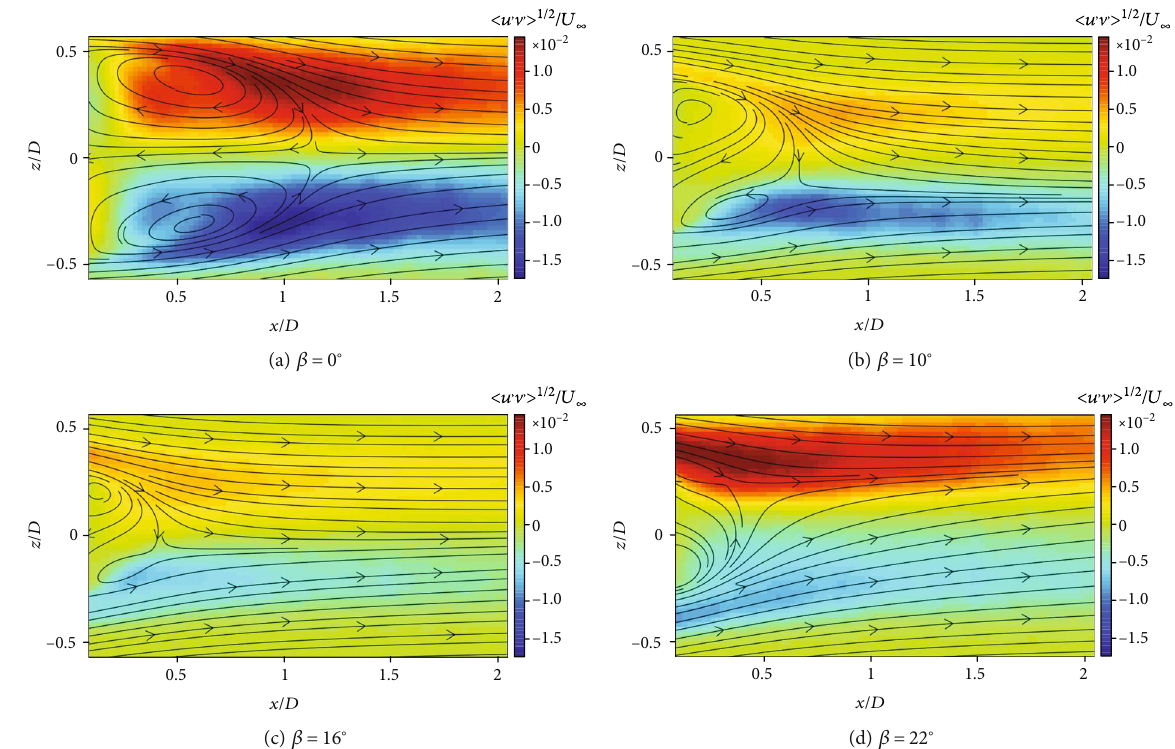
Figure 13: Reynolds shear stress distribution (a) β = 0 ° , (b) β = 10 ° , (c) β = 16 ° , and (d) β = 22 ° .